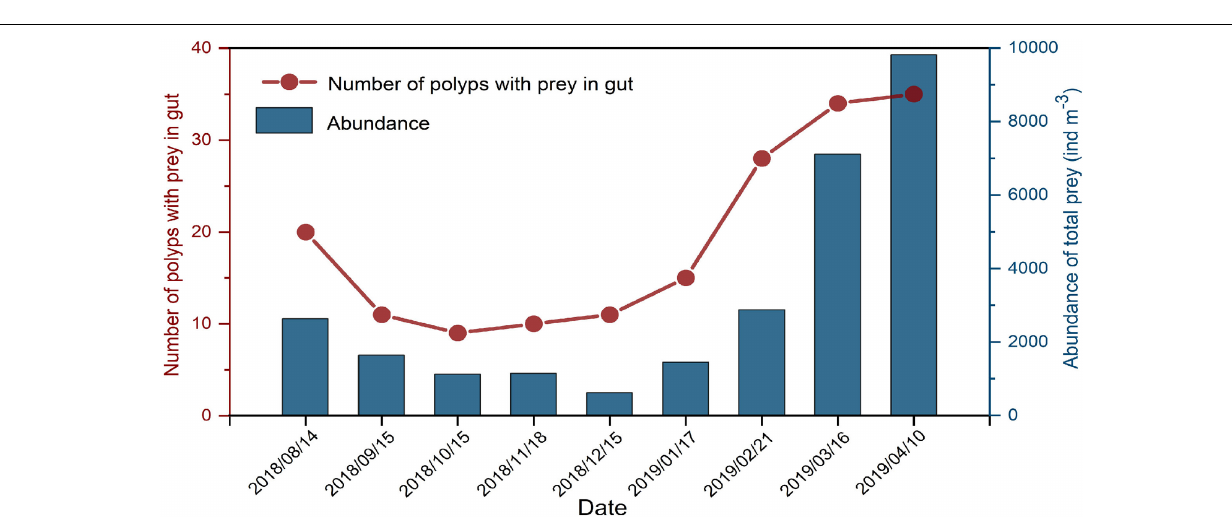
FIGURE 5 | The relationship between the number of polyps with prey in gut (50 polyps were collected on each sampling date) and abundance of zooplankton (ind m − 3 ) during the study period. A Spearman correlation test showed that the number of polyps with prey in gut was significantly correlated with zooplankton abundance ( R 2 = 0.904, P = 0.001, n =